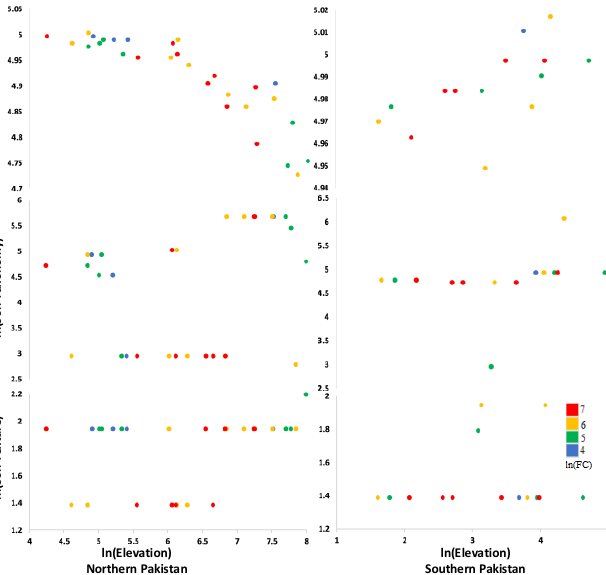
Figure 9. Monthly FC in North and Southern Pakistan as a function of a mix of regional mean soil properties and topography index (elevation) from 2001 to